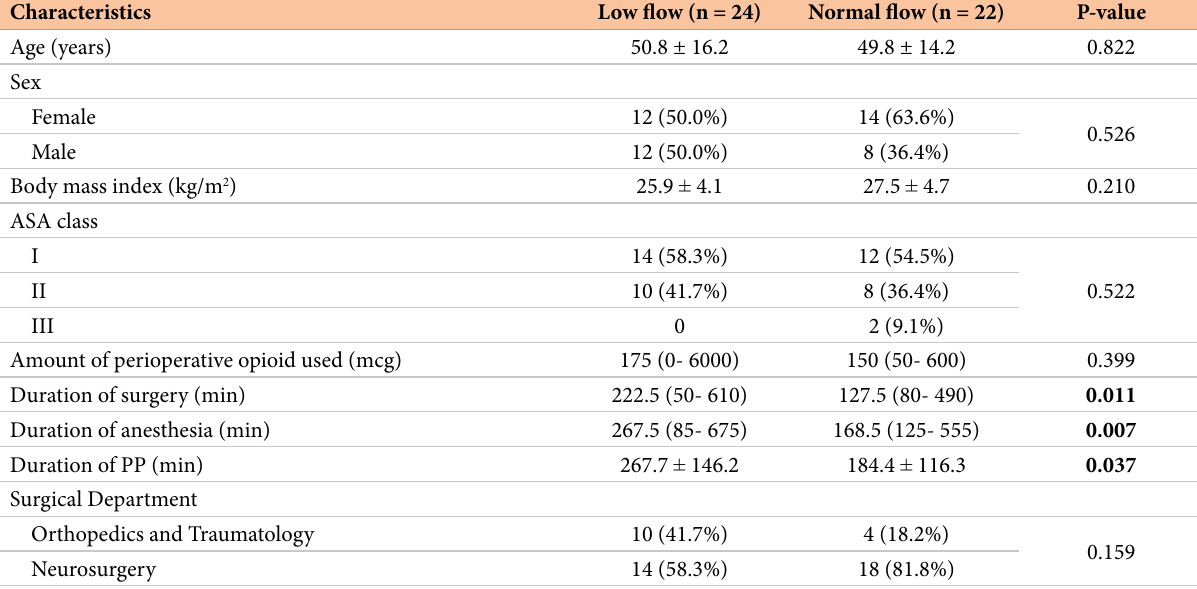
Table 1 – Comparison of minimal-flow and normal-flow anesthesia patients in terms of clinicodemographic characteristics, surgery, and anesthesia